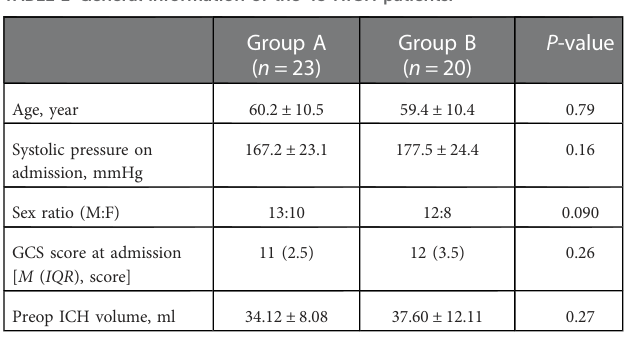
TABLE 1 General information of the 43 HICH patients.